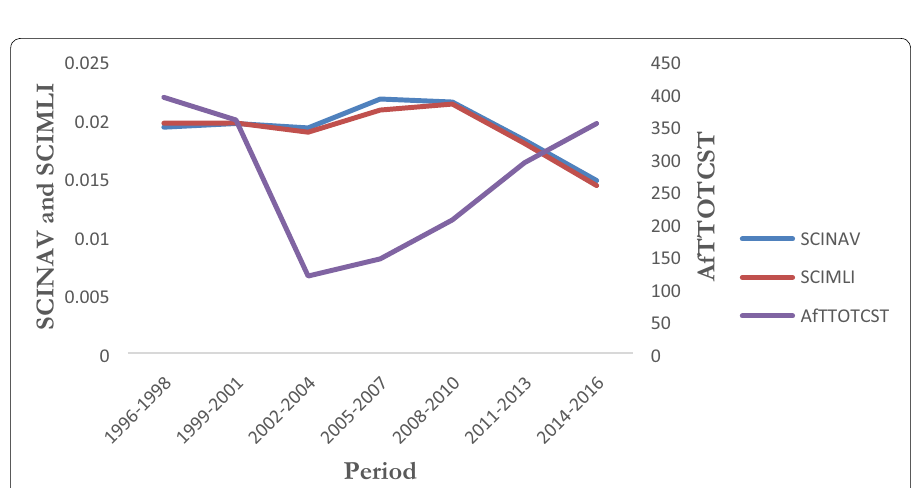
Fig. 2 Evolution of SCINAV and AfTTOTCST. Total Aid for Trade (AfTTOTCST) is expressed in millions US Dollars, constant 2016 prices (Source: